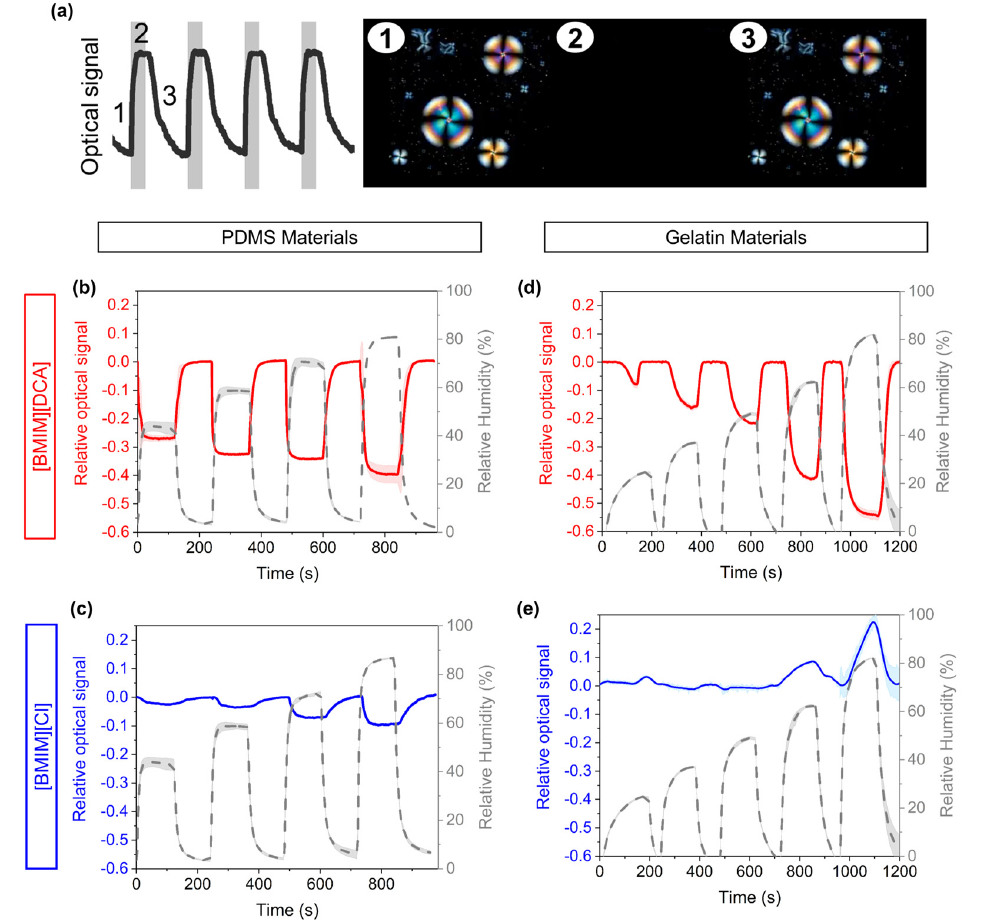
Figure 3. Relative optical signals of the sensing films to varying relative humidity. ( a ) Typical profile of the relative optical signals obtained during VOC-exposure and recovery cycles, as well as the corresponding optical morphological changes observed by POM in the hybrid gels during those cycles. ( b ) Signals yielded by a film composed of PDMS, [BMIM][DCA] and 5CB; ( c ) signals yielded by a film composed of PDMS, [BMIM][Cl] and 5CB; ( d ) signals yielded by a film composed of gelatin, [BMIM][DCA] and 5CB; ( e ) signals yielded by a film composed of gelatin, [BMIM][Cl] and 5CB. The plots illustrate representative examples of the signals of a single sensor exposed to different RH step changes.